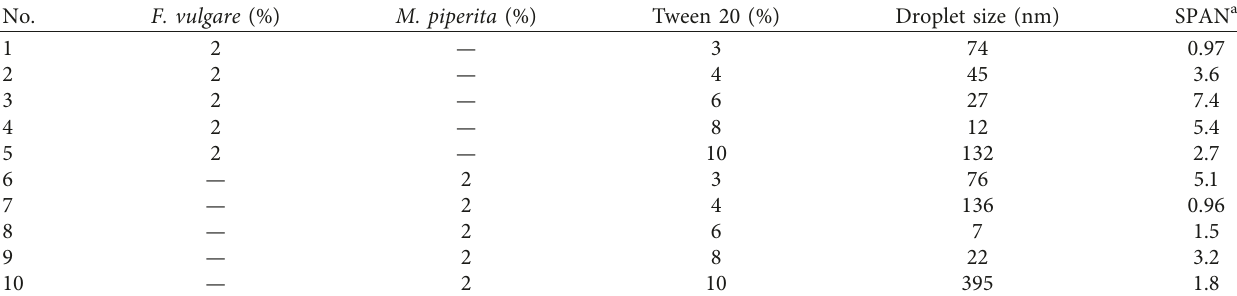
Table 1: Prepared nanoemulsions and their size analyses.